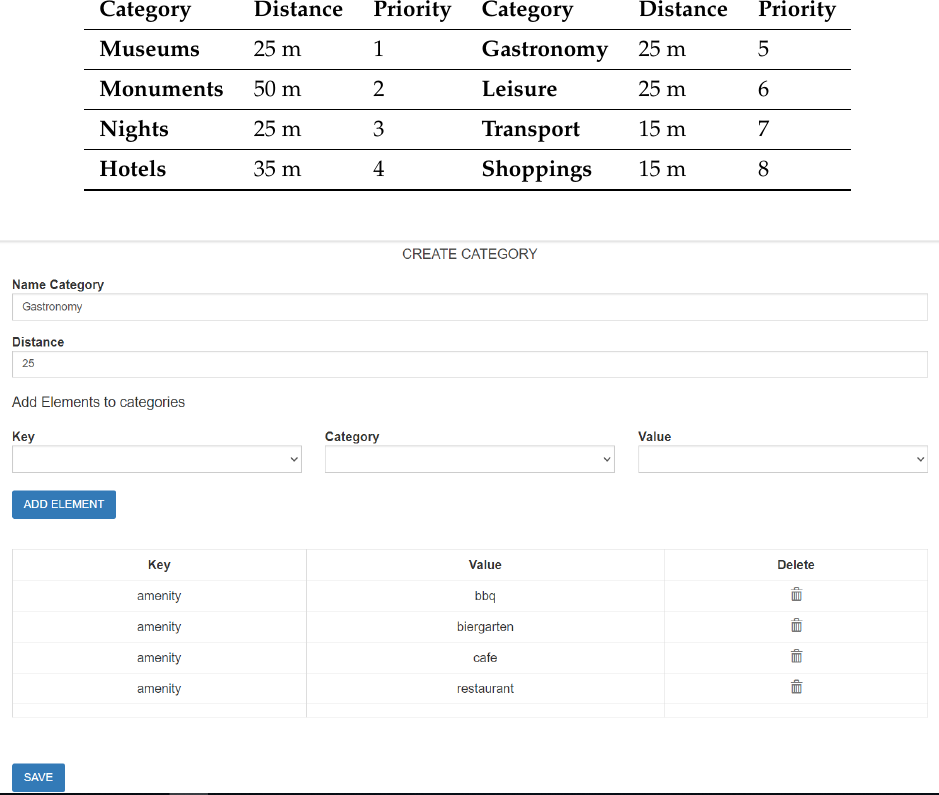
Figure 5. Configuration of each